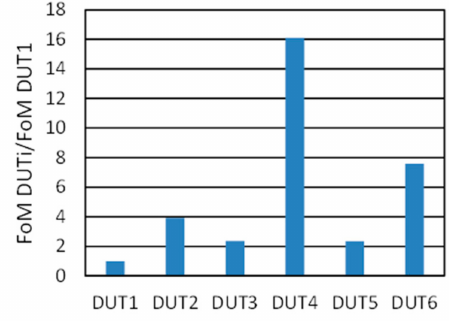
Figure 13. Comparison of the proposed FoM of the